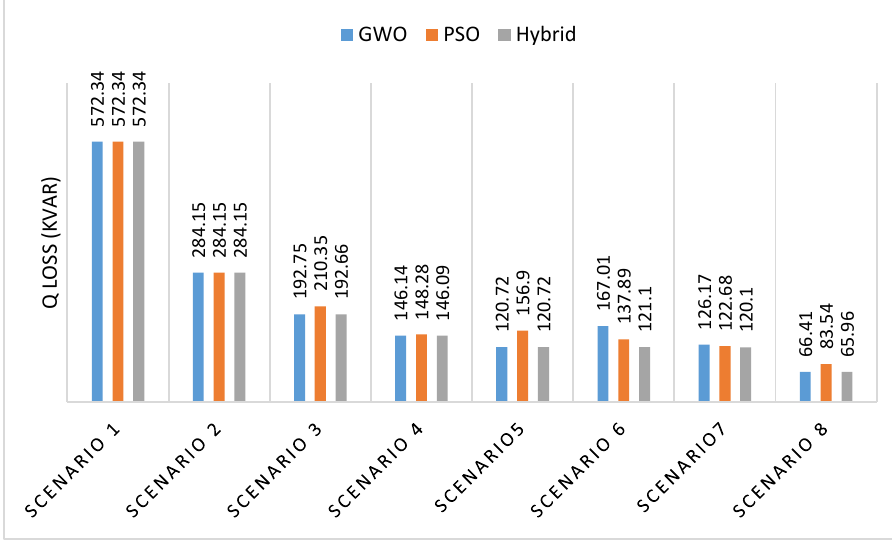
Figure 14. Reactive loss of the 78-bus system using three different techniques.